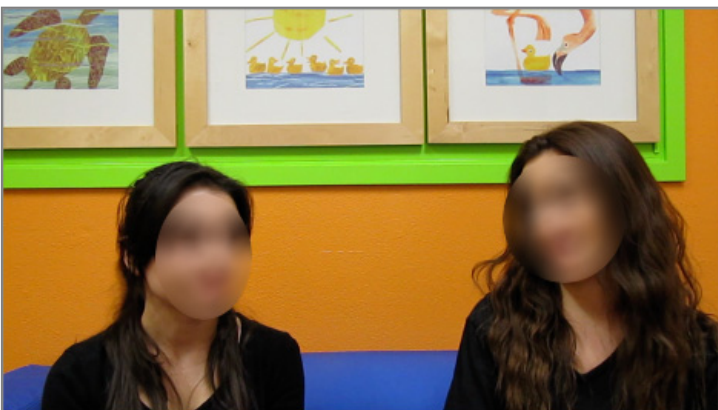
Figure 1. An example frame from a video used in the free-viewing task. In all six videos, the woman on the left (coded as speaker 1) was always seated on the left-hand side of the screen, and the woman on the right (coded as speaker 2) was always seated on the right-hand side of the screen. It should be noted that the faces are only blurred here to protect the privacy of the actors; the faces were not blurred in the actual stimuli presented to the infants.